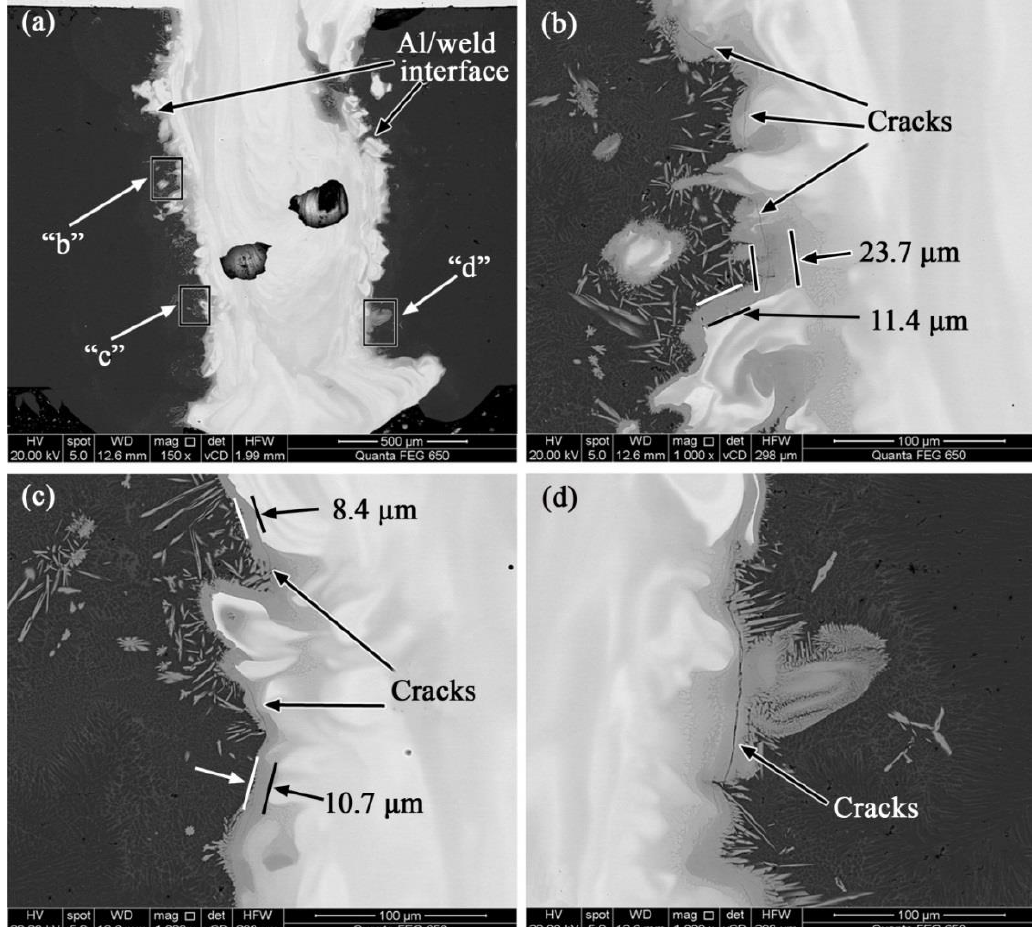
Figure 6. Backscatter electron (BSE) images of the Al/weld interface of the steel/Al joint having a P2 of 1741 μm produced by dual -beam laser welding with side-by-side configuration: ( a ) Cross section of the weld and the location of rectangle of Zone “b”–“d”; ( b ) Enlarged view of Zone “b”; ( c ) Enlarged view of Zone “c”; ( d ) Enlarged view of Zone “d”.